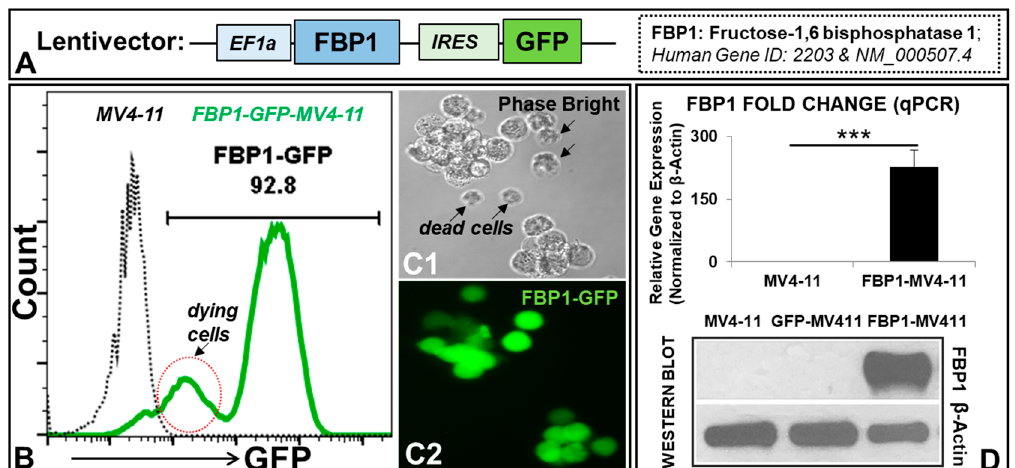
Figure 1. Generation of an AML cell line genetically bioengineered to overexpress FBP1 (FBP1-MV411 blast) in vitro: ( A ) Schematic diagram of the lentiviral expression construct containing the human FBP1 open reading frame (ORF) and GFP reporter, with the EF1a and IRES promoters, respectively. ( B ) A representative FC histogram showing GFP expression in FBP1-MV4-11 (FACS-sorted, see Materials and Methods) and MV4-11 cells; dying cells have weak GFP expression, indicated by a red circle. ( C1 ) A representative phase-bright image (20 × ) of FBP1-MV4-11 cells; dying cells are indicated by arrows. ( C2 ) A fluorescent image (20 × ) of the same FBP1-MV4-11 cells from ( C1 ) showing GFP expression in viable cells, while dead cells no longer display fluorescence. ( D ) Overexpression of the FBP1 gene and protein in the FBP1-MV4-11 cell line, as confirmed by qPCR (fold change, upper panel) and Western blot assays (lower panel); the lentiviral empty construct has a GFP reporter without the FBP1 ORF as the control (GFP-MV4-11). Where applicable, data are means ± SEM, and were analyzed by Student’s “ t ”-test; *** p < 0.005, n = 3.